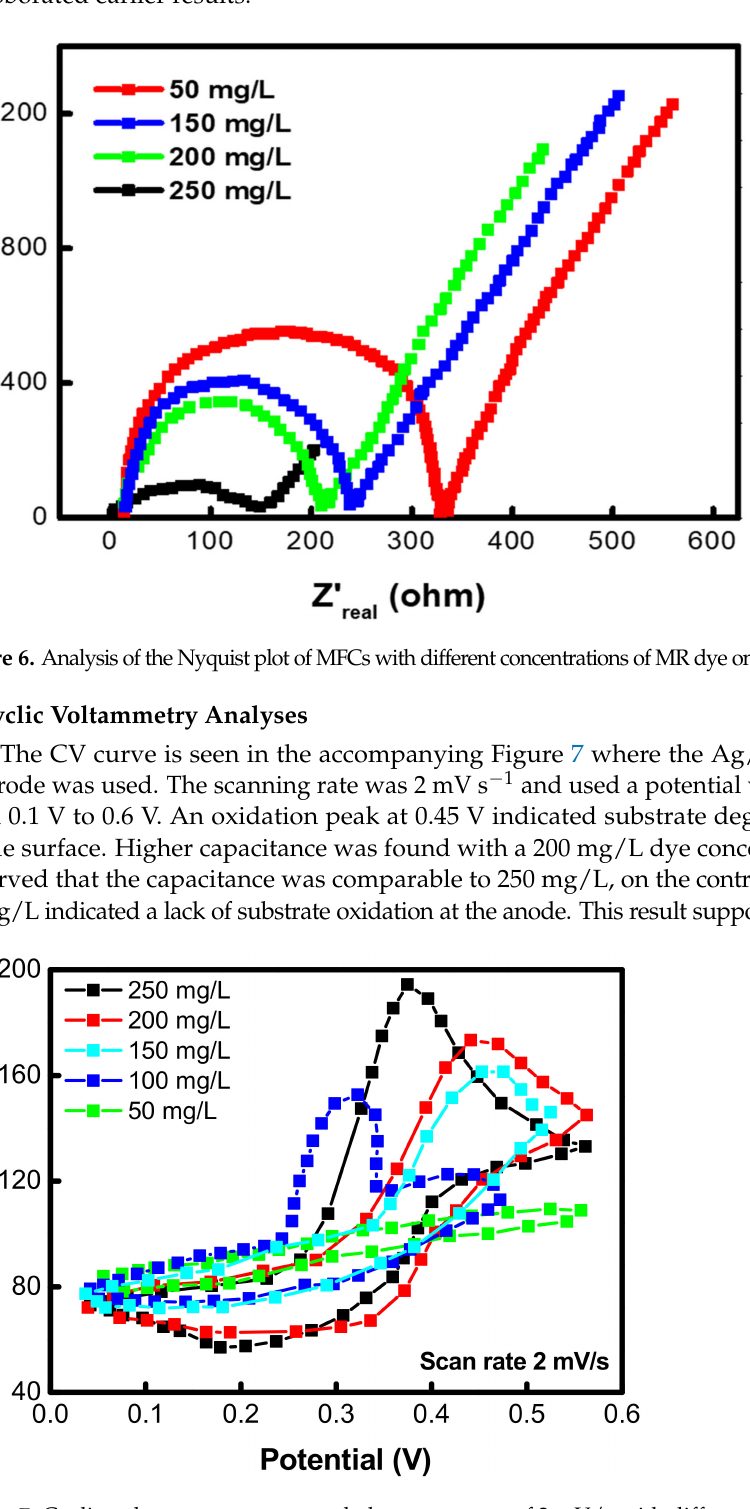
Figure 7. Cyclic voltammetry was recorded at a scan rate of 2 mV/s with different concentrations of methyl red dye on the